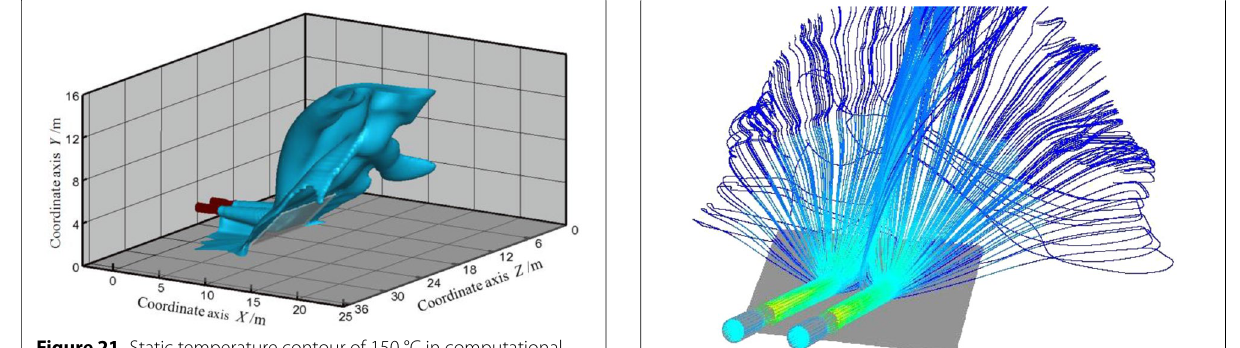
Figure 23 Path lines of gas jet from twin engines